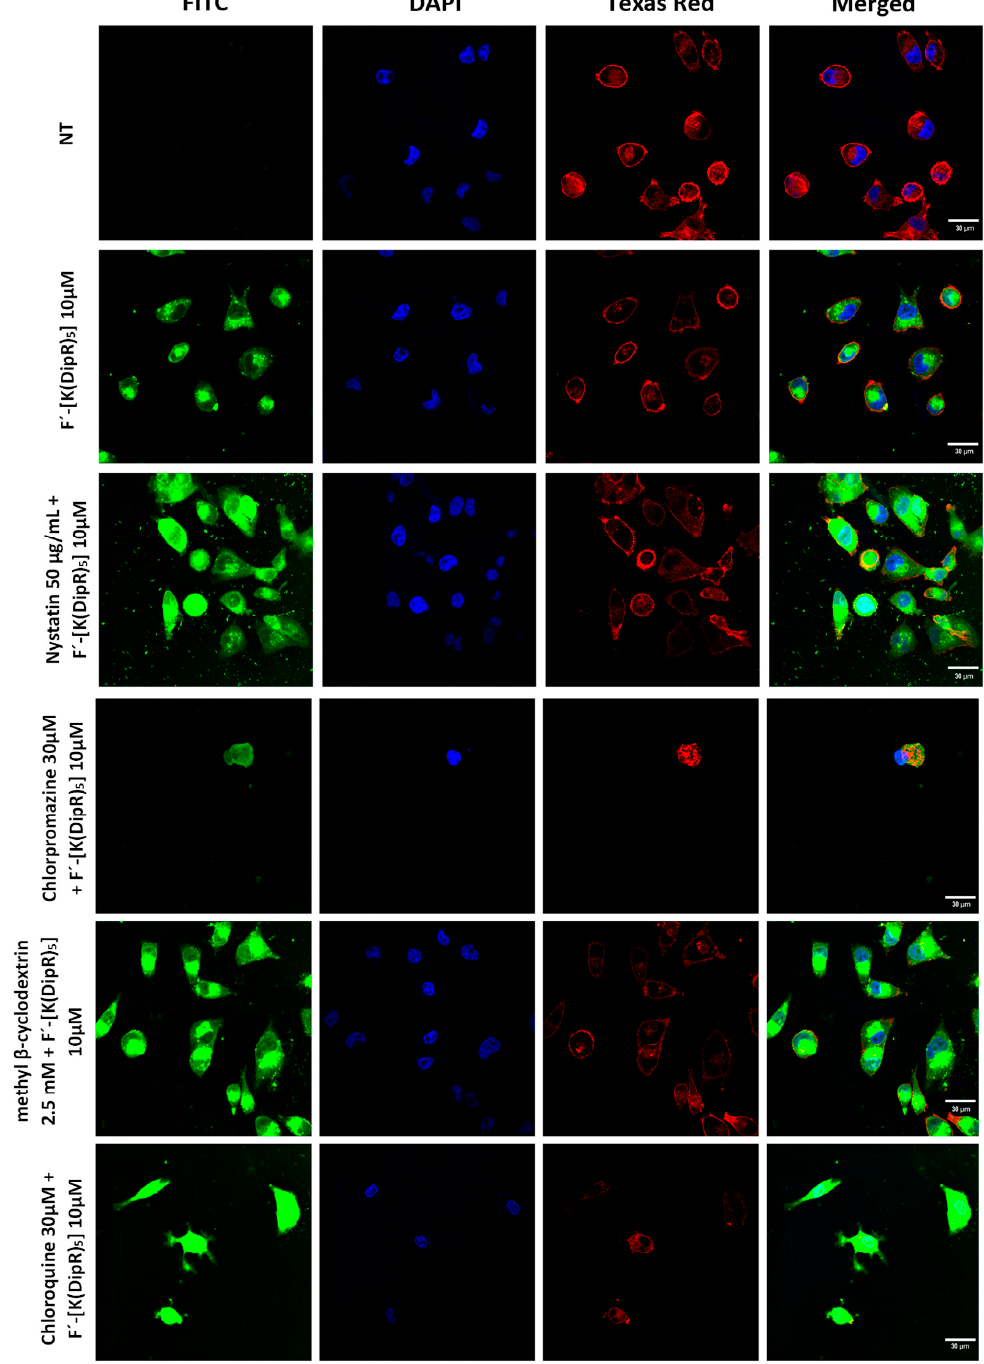
Figure 15. Confocal microscopy of F’-[K(DipR) 5 ] (10 µM) and endocytosis inhibitors (nystatin (50 µg/mL), chloroquine (100 µM), chlorpromazine (30 µM), and methyl- β -cyclodextrin (2.5 mM)) in MDA-MB-231 cells after 3 h incubation (NT = No Treatment). MDA-MB-231 cells after 3 h incubation (NT = No